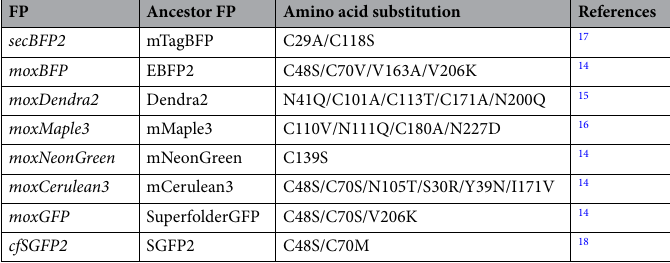
Table 1. Amino acid substitutions in moxFPs.